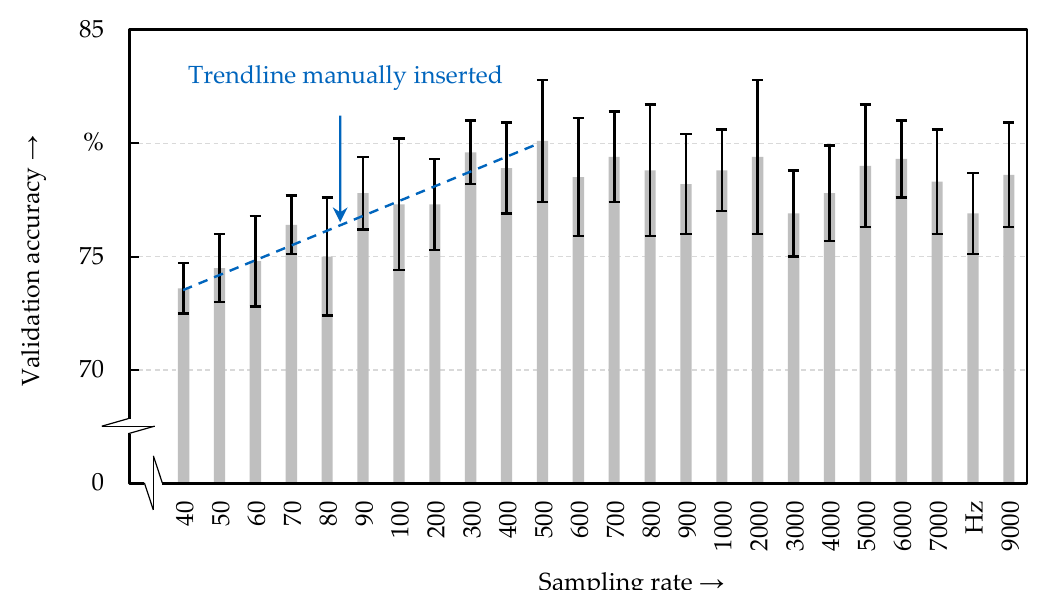
Figure 6. Validation accuracy depending on the sampling rate for the evaluation of the y -force using a convolutional neural network (CNN).